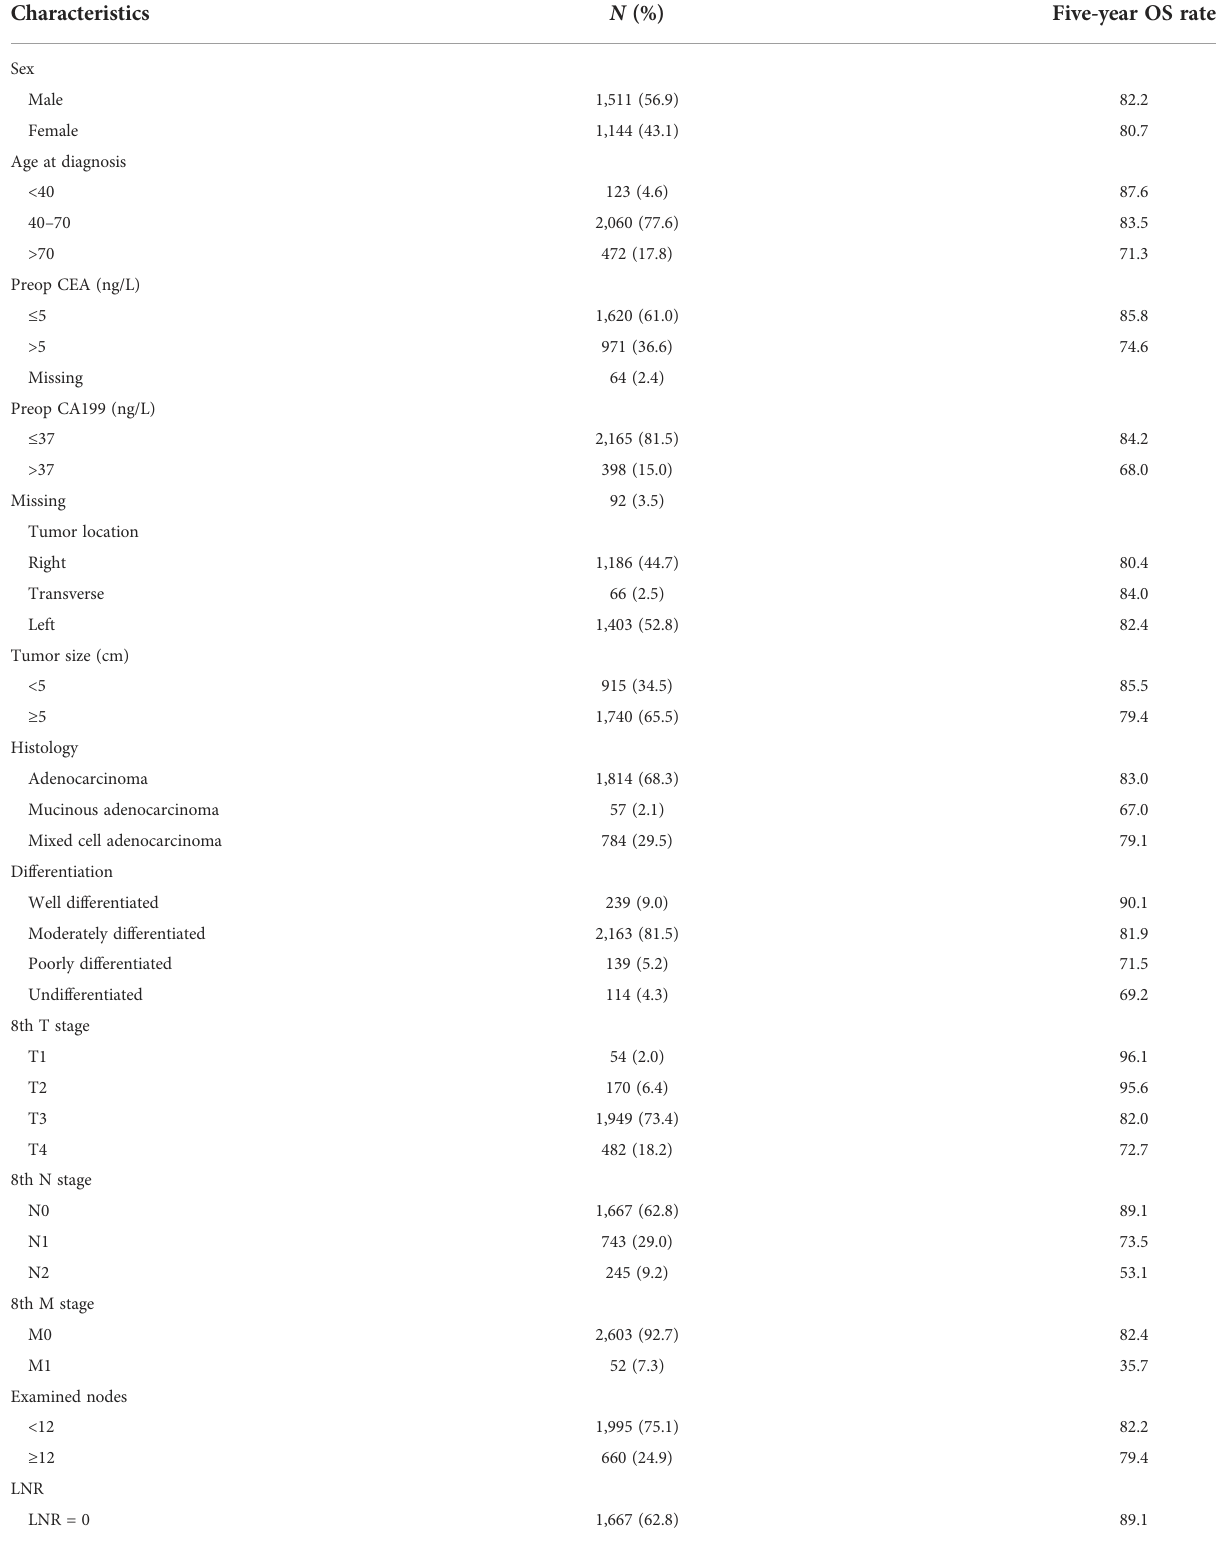
TABLE 1 Clinical and pathological characteristics of the study